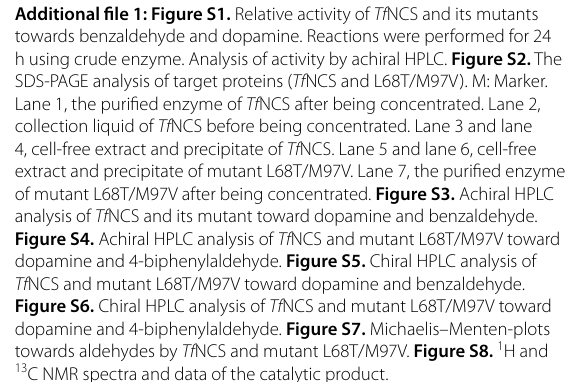
Figure S4. Achiral HPLC analysis of Tf NCS and mutant L68T/M97V toward dopamine and 4‑biphenylaldehyde. Figure S5. Chiral HPLC analysis of Tf NCS and mutant L68T/M97V toward dopamine and benzaldehyde. Figure S6. Chiral HPLC analysis of Tf NCS and mutant L68T/M97V toward dopamine and 4‑biphenylaldehyde. Figure S7. Michaelis–Menten‑plots towards aldehydes by Tf NCS and mutant L68T/M97V. Figure S8. 1 H and 13 C NMR spectra and data of the catalytic